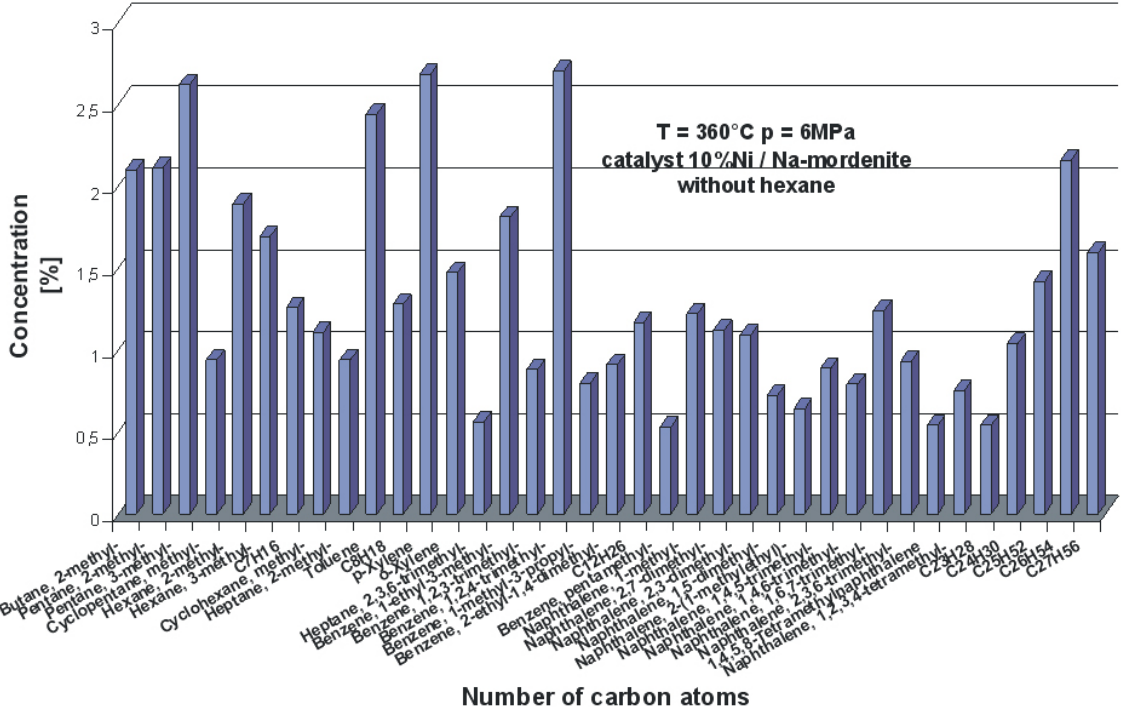
Figure 8. Hydroconversion of LTP56-H paraffin conducted for 4 h at 360°C over 10%Ni/Namordenite and in the pressure range 60-380 bar (without hexane, catalyst after reduction at 400°C in pure hydrogen for 2 Table 2. The effects of none-catalytic thermal treatment and reaction conditions (solvent) on the selectivity of liquefaction LTP56-H paraffin process carried out over Ni/Na-mordenite catalysts (paraffin : hexane weight ratio = 1:3, g LTP56-H/g catalyst = 3, time = 4 h). Catalyst